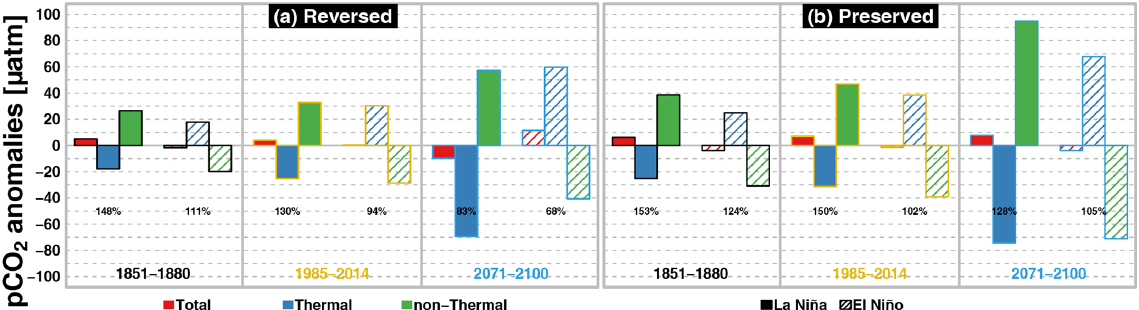
Figure 6. El Niño and La Niña average of total (in red), thermal (in blue), and non-thermal (in green) p CO 2 mean anomalies (in µatm) for the reversed (a) and preserved (b) ESMs over the early historical (1851–1880), contemporary (1985–2014), and future (2071–2100) periods in the EP domain. The absolute ratio between the non-thermal and thermal components is given (in %) for each period, group, and ENSO phase.